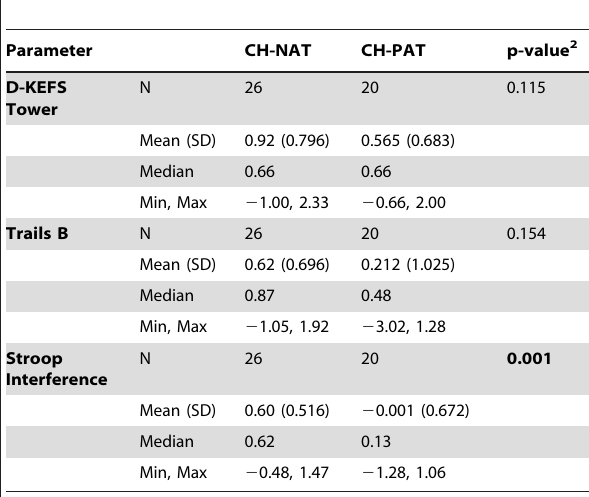
Table 5. Neuropsychological tests within the core executive domain in the cognitively healthy study population 1